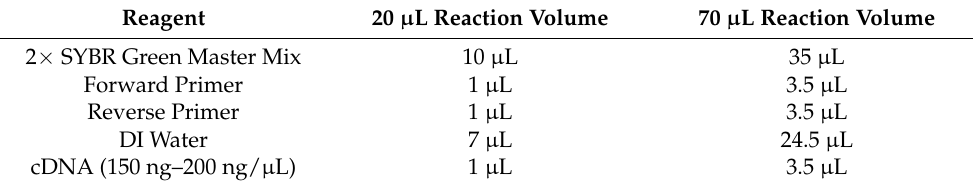
Table 1. Reaction conditions used for qRT-PCR analysis.